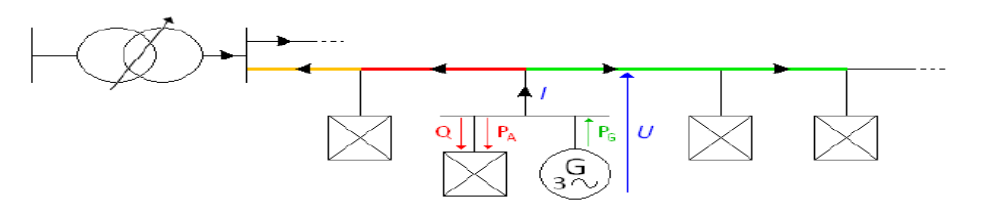
Figure 19. Reverse power flow issue.